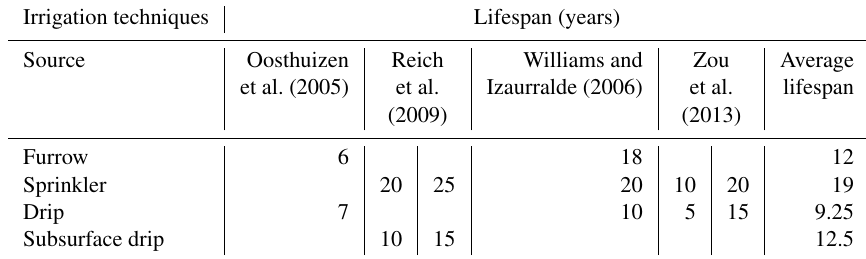
Table B1. Estimates of the lifespan of irrigation techniques from various